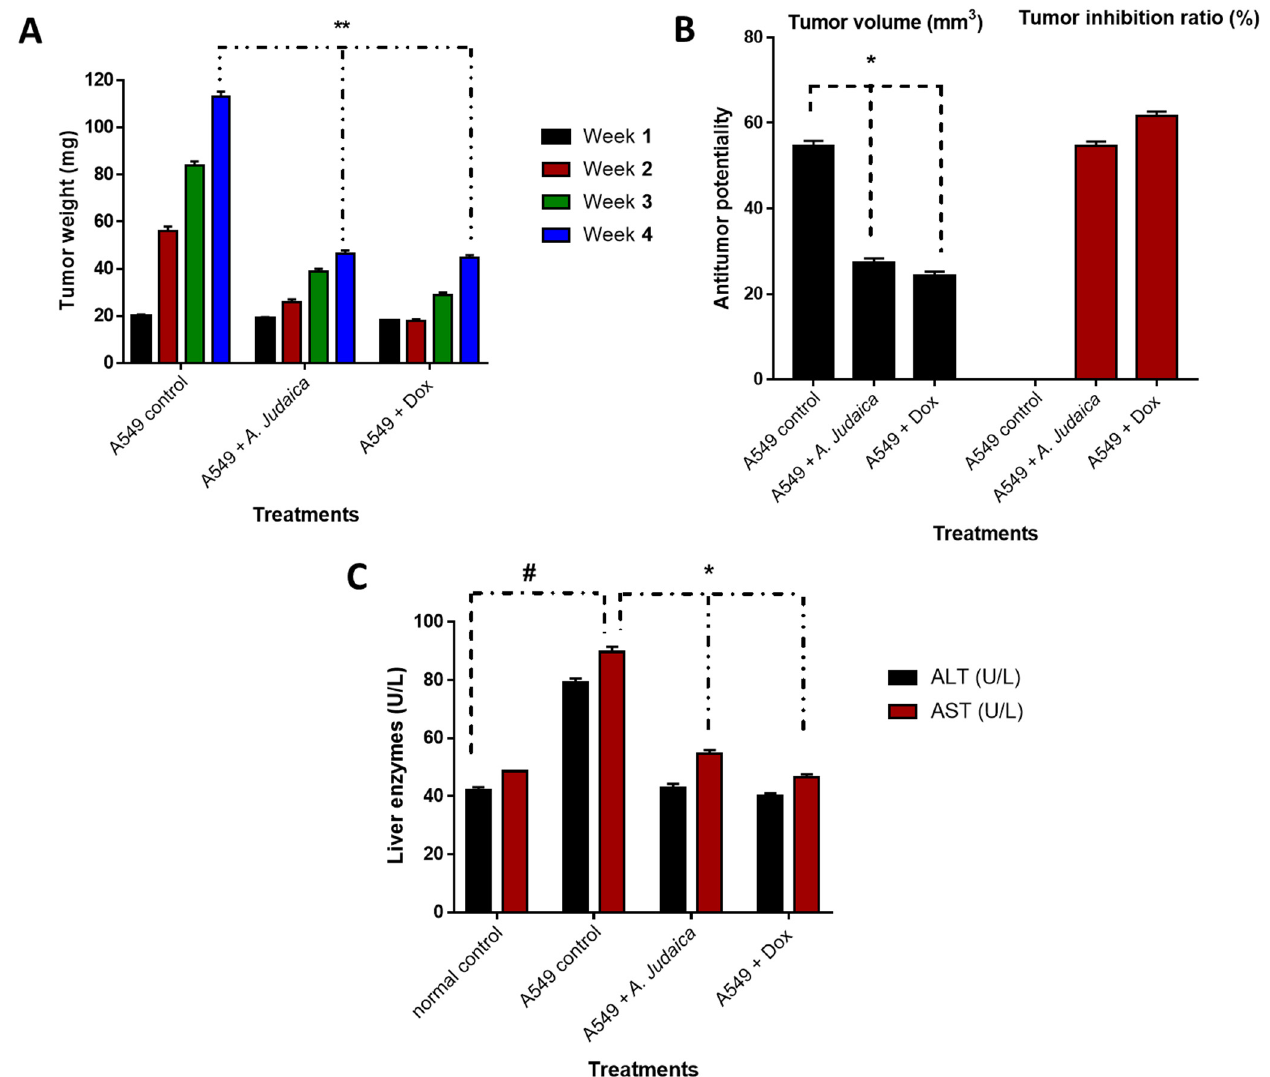
Figure 4. Anticancer activity of A. judaica L. and doxorubicin in the A549 group (Xenograft model) compared to in the control group. ( A ): Solid tumor mass (mg) during the experimental duration (4 weeks); ( B ): antitumor potentiality of tumor volume (mm 3 ) and tumor inhibition ratio (TIR%); ( C ): biochemical measurements of liver enzymes (Alt and AST). Values are expressed as Mean ± SD values of mice in each group ( n = 6). Sign (*) is significantly different ( p ≤ 0.05), while sign (**) is highly significantly different ( p ≤ 0.001) between the A549 control group and those treated using unpaired test GraphPad prism. Sign (#) is significantly different ( p ≤ 0.05) between the normal control group and the A549 control group.